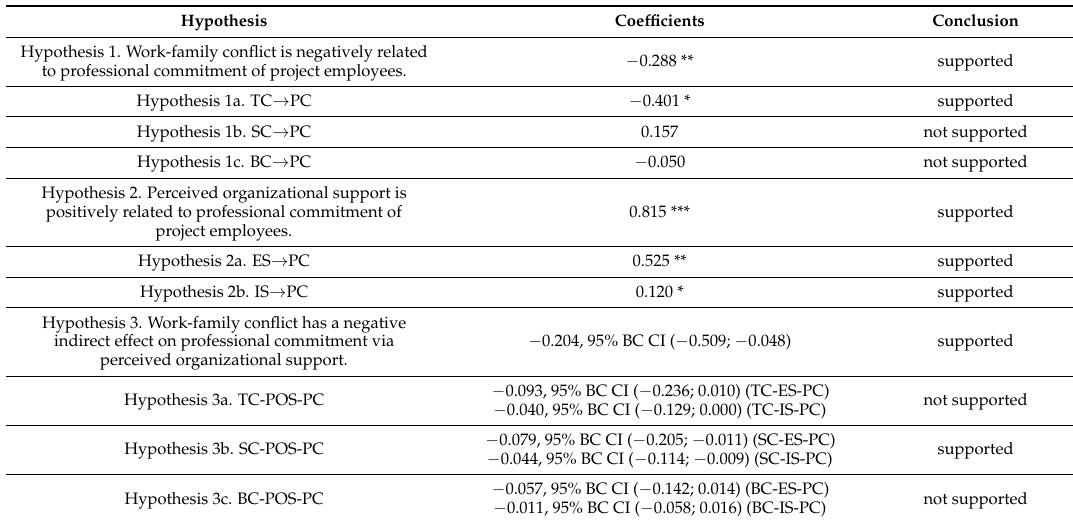
Table 10. Results of hypothesis